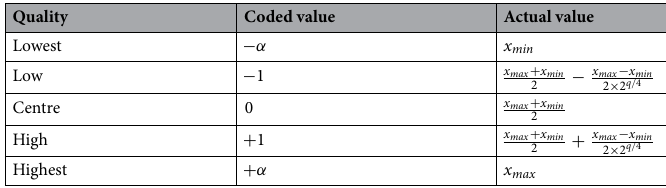
Table 1. Relationship between coded and actual values of a variable. Where x min and x max are respectively the minimum and maximum values of x , and q is the number of